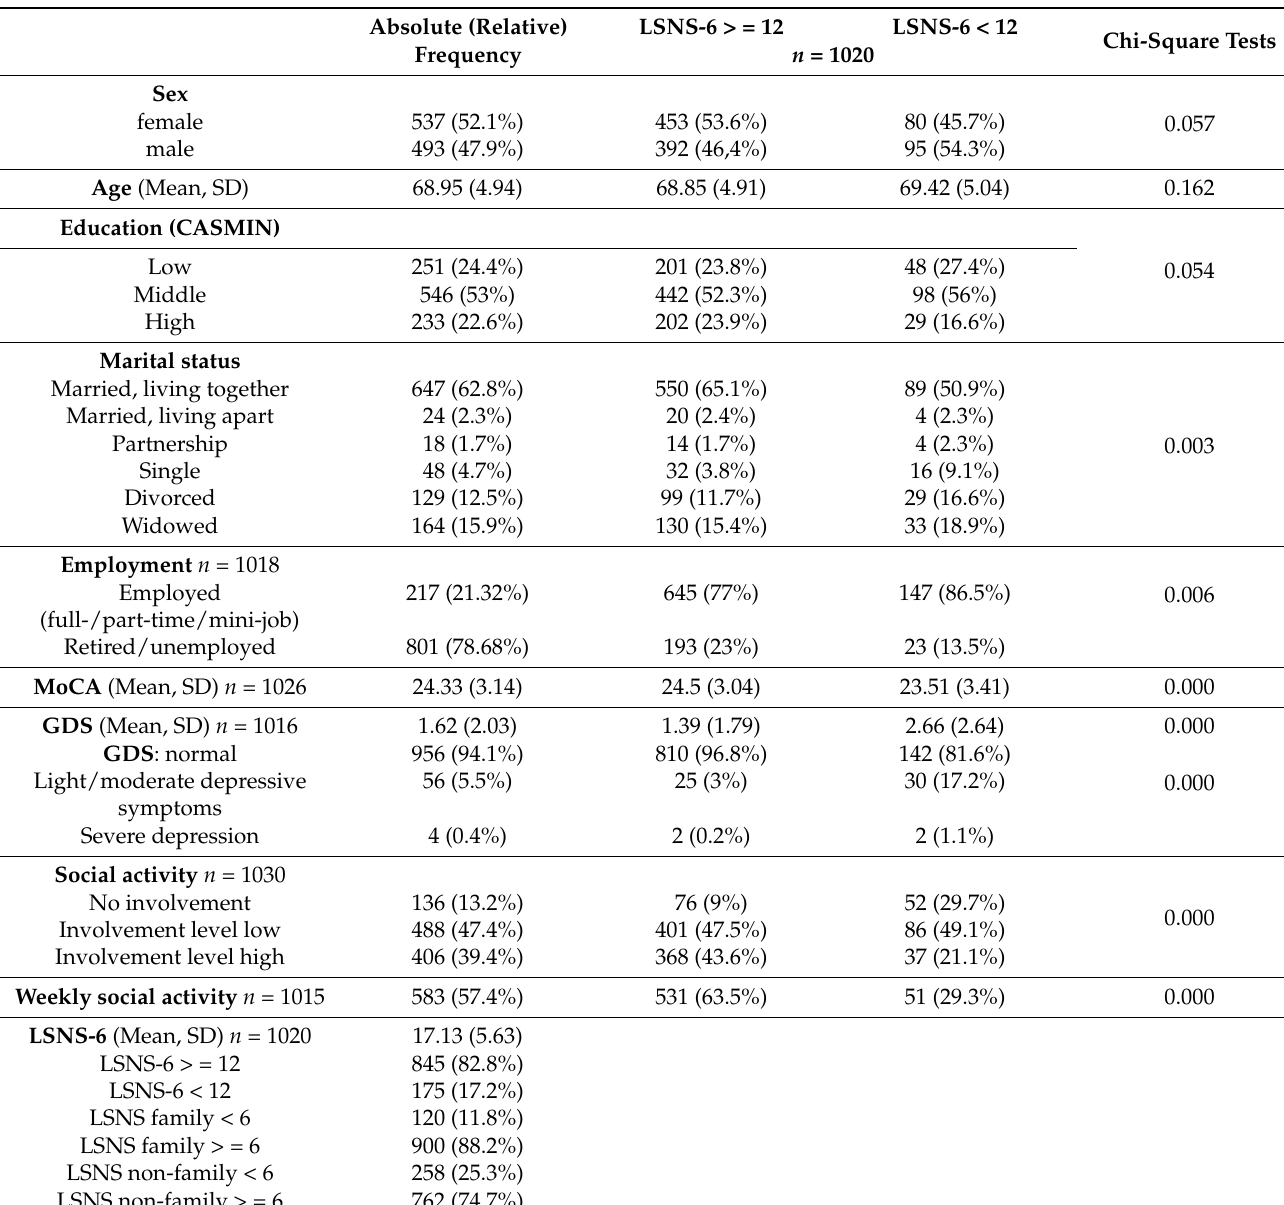
Table 1. Characteristics of included patients ( n = 1030).